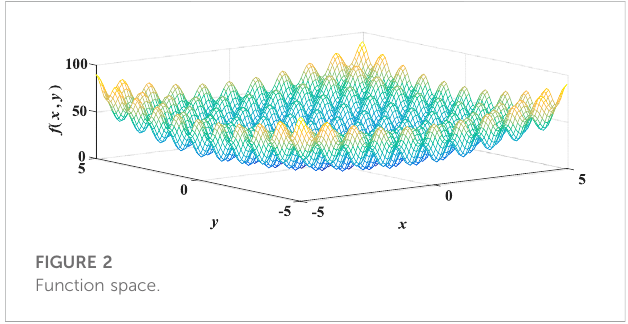
FIGURE 2 Function space.